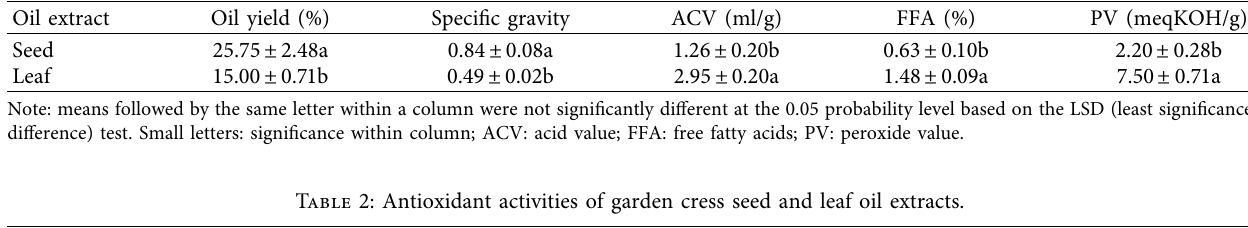
Table 1: Physicochemical properties of garden cress seed and leaf oil